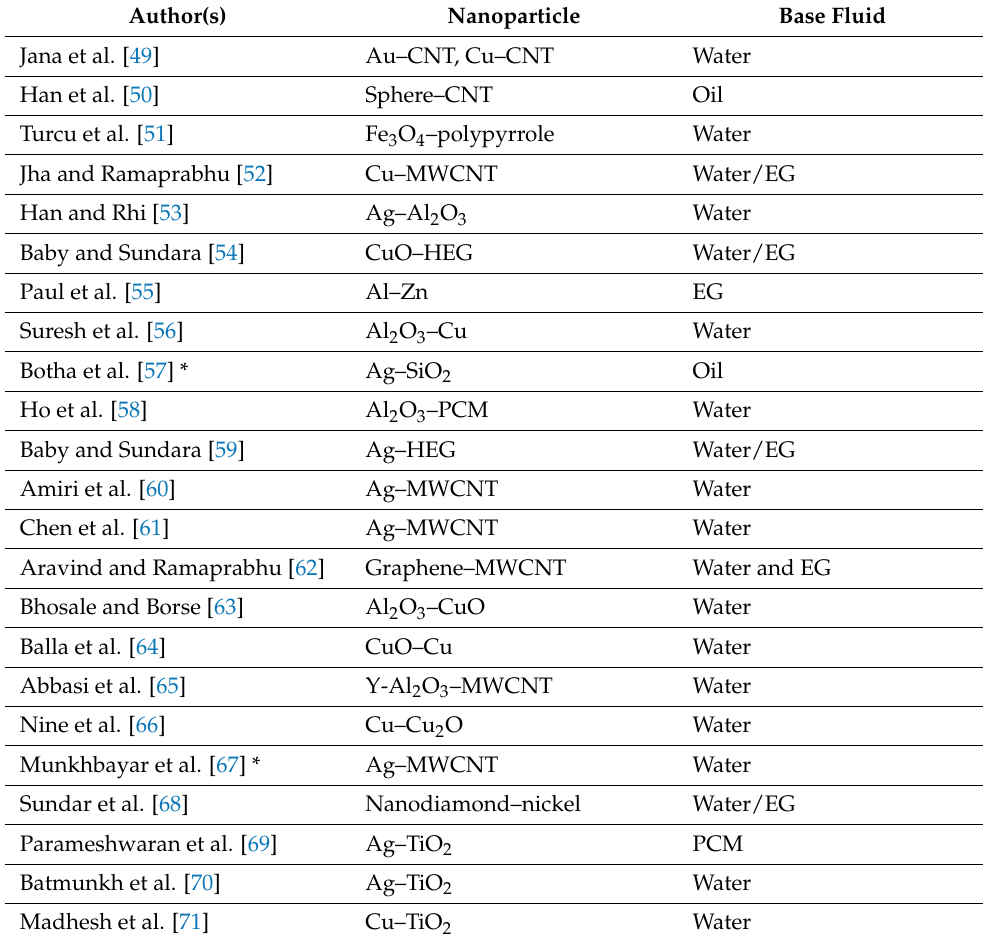
Figure 2. Flowchart for producing hybrid nanofluids [48]. Table 1. Examples of hybrid nanofluids adopting two-step preparation.